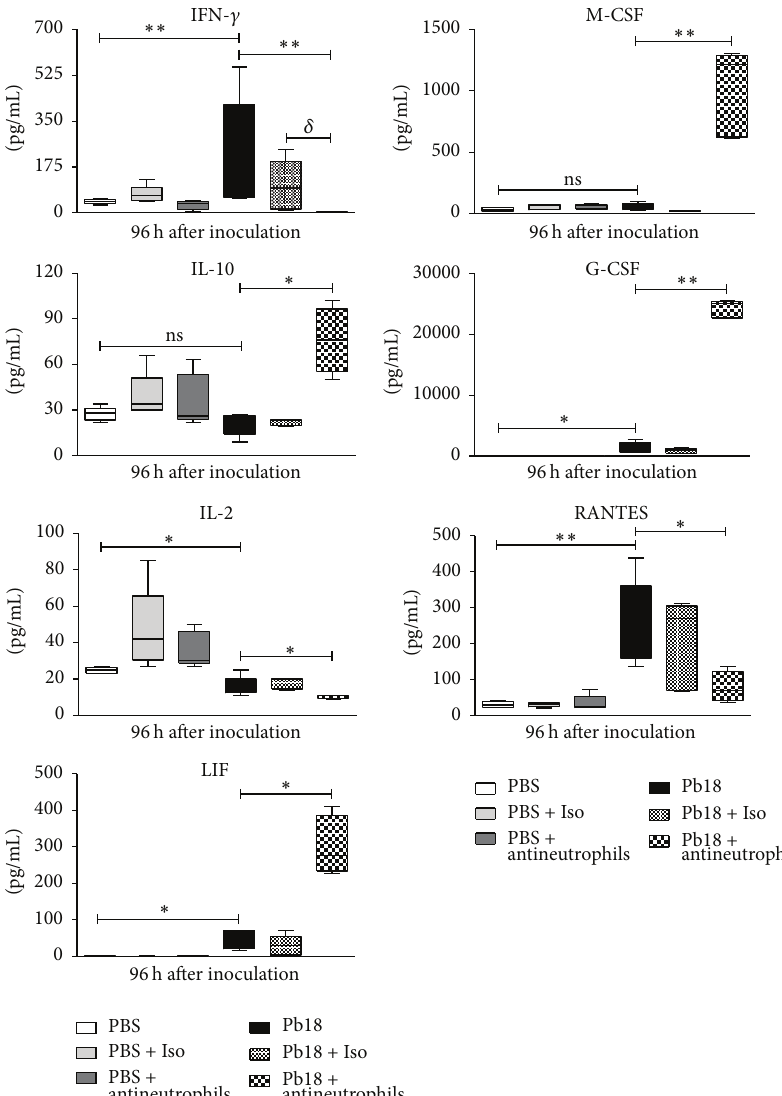
Figure 5: Depletion of neutrophils increases levels of growth factors, IL-10, and LIF but decreases IFN- 𝛾 , IL-2, and RANTES in lungs of mice infected with P. brasiliensis during the early stages of infection. BALB/c mice were challenged intranasally with 1.5 × 10 6 P. brasiliensis (Pb18) yeast cells and treated with an isotype control Ab or the anti-Ly6G mAb specific to neutrophils. Supernatants from lung homogenates of mice sacrificed at 96h after infection were analyzed using a commercial kit and the Luminex System as described in Material and Methods. Data shown represent median and IQR ( 𝑛 = 4 -5 mice/group; representative of two independent experiments). ∗ 𝑃 < 0.05 and ∗∗ 𝑃 < 0.01 comparing infected-untreated mice versus control mice or comparing infected-anti-Ly6G mAb-treated mice versus infected-untreated mice. 𝛿 𝑃 < 0.01 comparing infected-isotype control antibody-treated mice versus infected-anti-Ly6G mAb-treated mice. PBS, control mice; PBS + Iso, control mice treated with isotype control Ab (clone: 2A3); PBS + antineutrophils, control mice treated with anti-Ly6G mAb (clone: 1A8); Pb18, infected-untreated mice; Pb18 + Iso, infected mice treated with isotype control Ab; Pb18 + antineutrophils, infected mice treated with anti-Ly6G mAb; ns: not